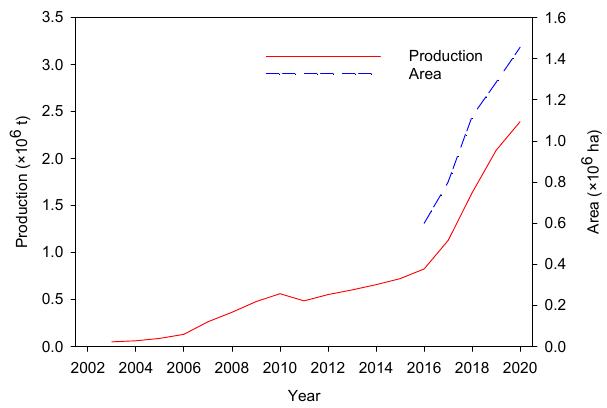
Figure 5. The red swamp crayfish aquaculture area and production from 2003 to 2020 in China [1].